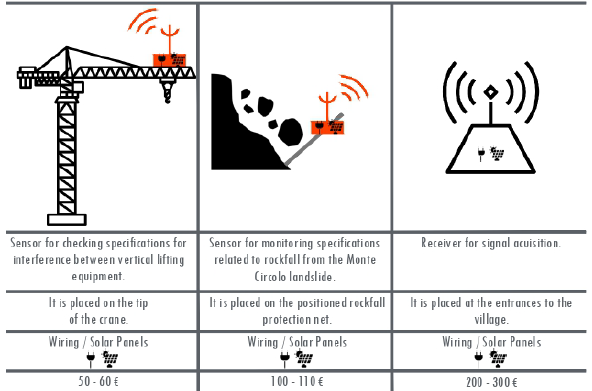
Figure 12. Schematic diagram of the sensors used. The sensors will be installed on the operator, on the vehicles, on the crane and in this particular case on the mountain to verify the fall of the rocks. All sensors will communicate with each other through a signal receiver. • Vehicles